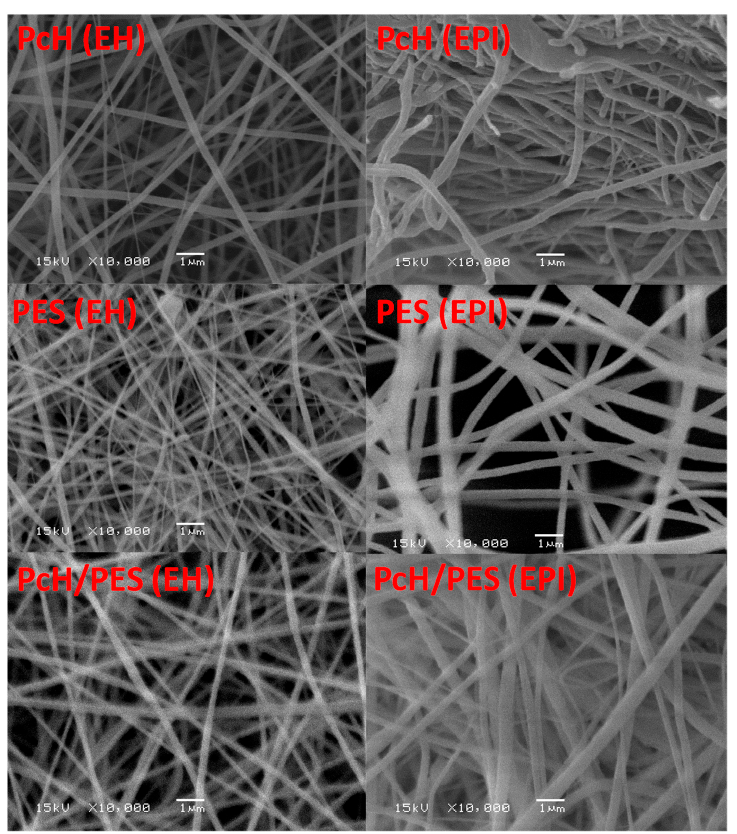
Figure 9. SEM imaging of pure PcH, pure PES, and PcH/PES blend membranes post-treated by heating at 60 °C (EH) and post-treated by phase inversion at 40 °C. ×10,000 was used.